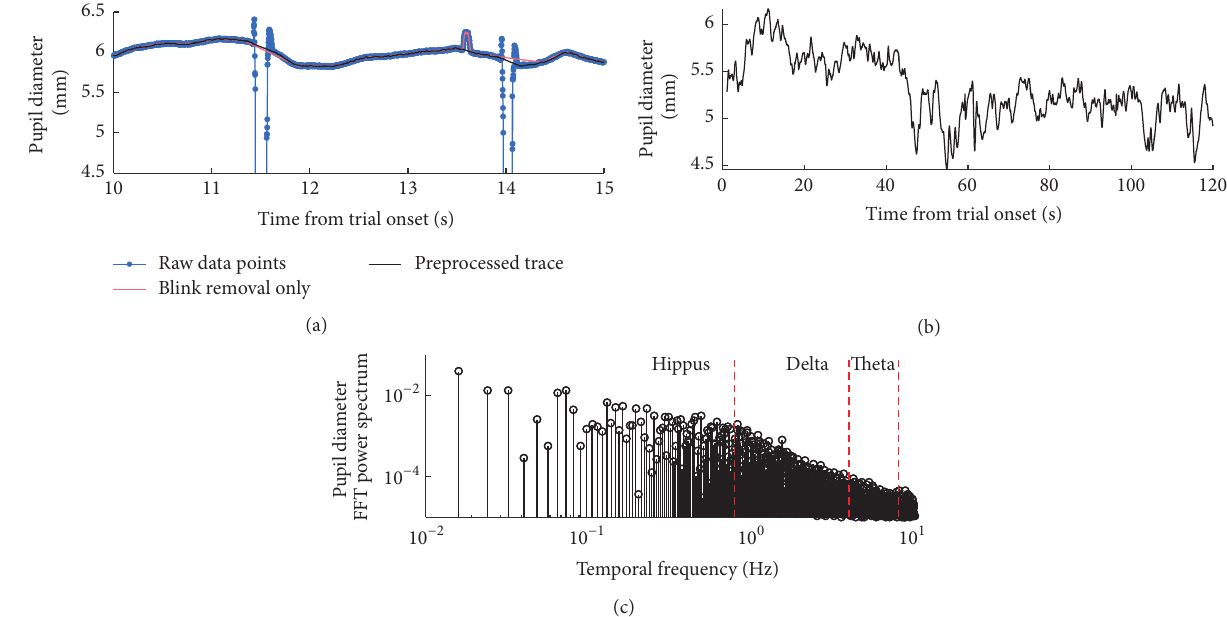
Figure 2: Preprocessing of pupillometry data. (a) Segment of pupil recording showing three artifacts: two typical blink artifacts and a short dilation artifact (eye-lashes disturbance). All three were removed by our preprocessing algorithm (black line). For comparison, the result of applying a more standard blink removal algorithm is shown by the red line. (b) Full preprocessed trace, same block from which the segment in (a) was extracted. (c) FFT spectrum of the pupil recording in (c), highlighting the frequency bands used in the main analysis. For this trace, the PUI value was